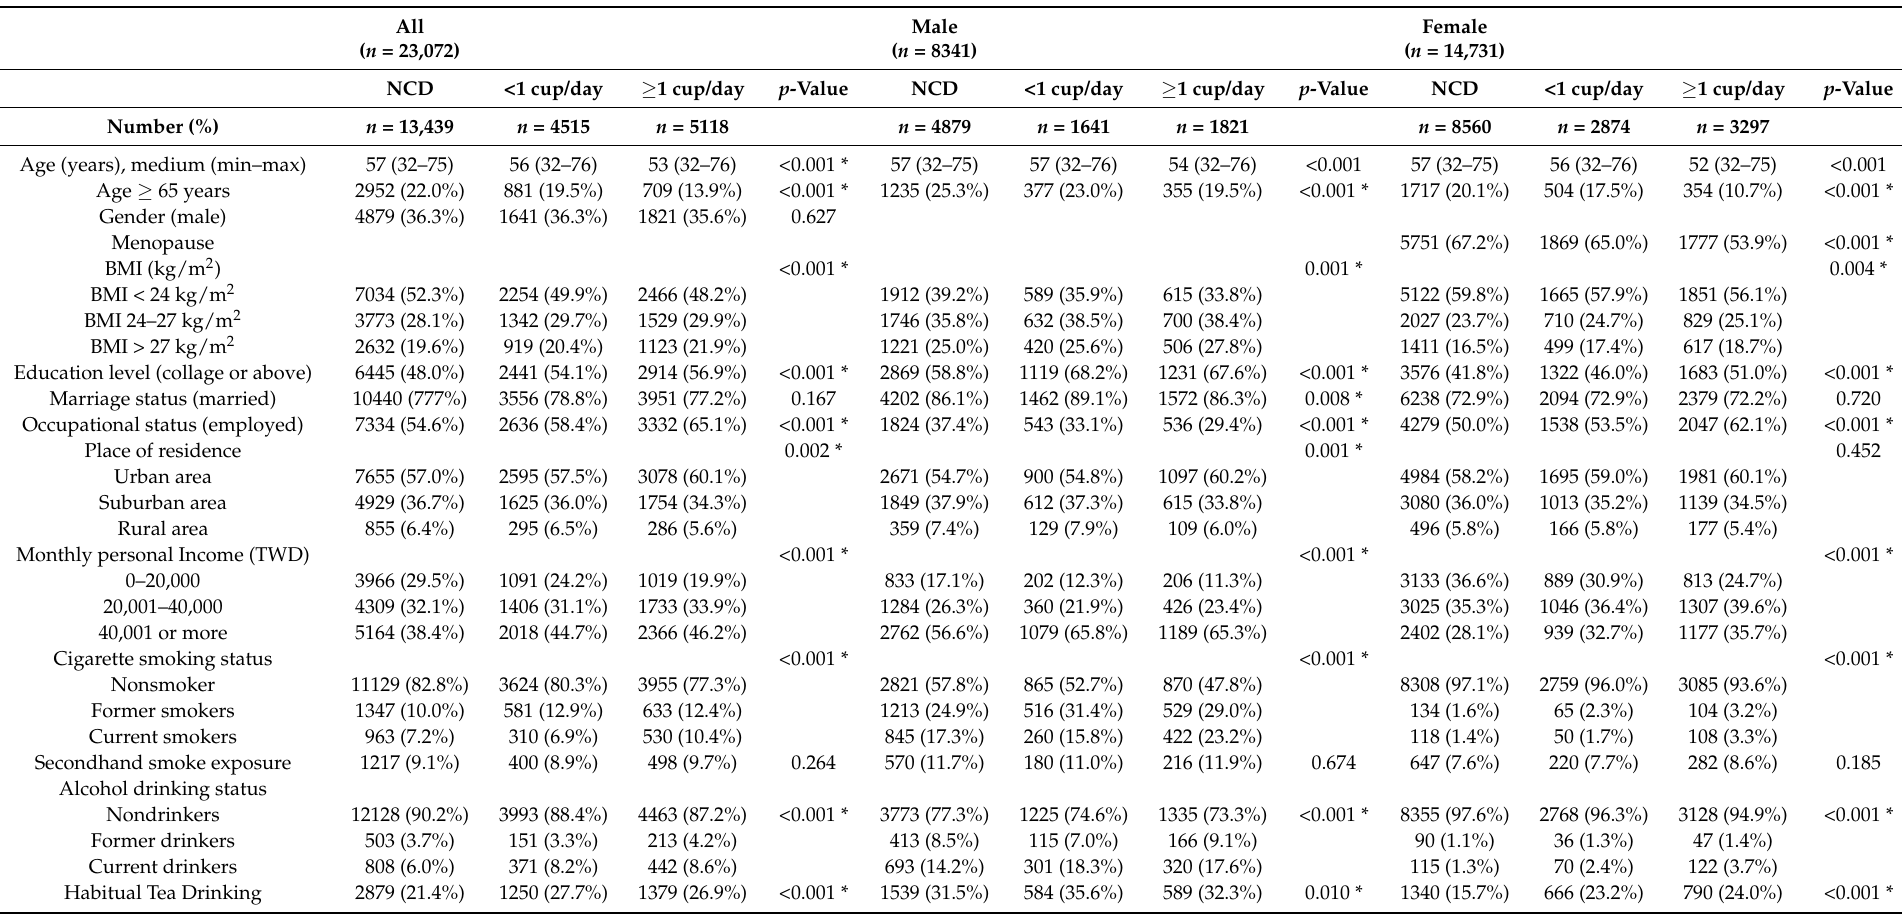
Table 1. The general characteristics and metabolic parameters according to different daily coffee drinking volume in Taiwanese participants aged 30–79